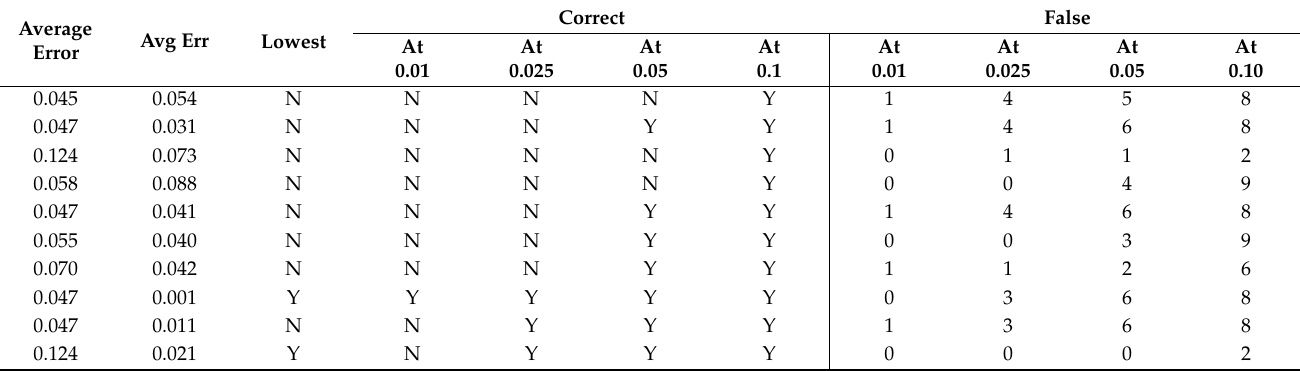
Table A123. Set 2, trials 21–30 summary data (all 0.5 PR values).